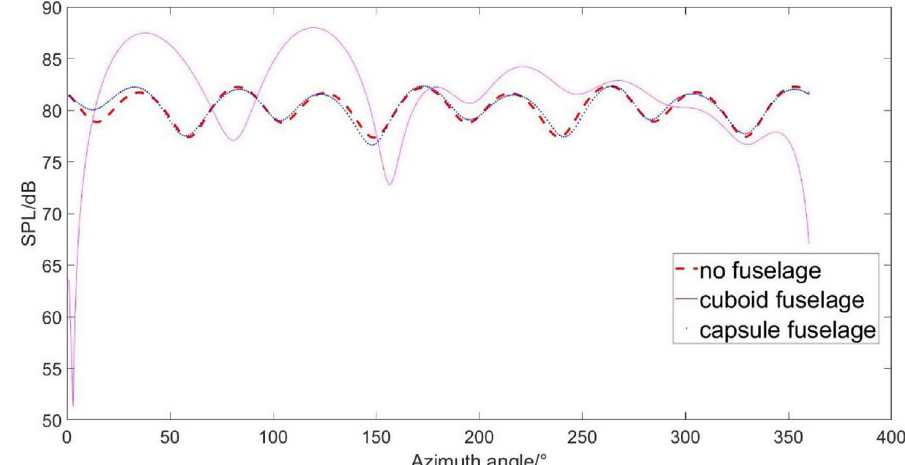
Figure 12. Acoustic noise scattering effects of cuboid fuselage and capsule fuselage. Table 3. Total and maximum SPL of helicopters with cuboid and capsule fuselages. Fuselage No fuselage Cuboid Capsule Total sound pressure level/dB 80.35 Maximum sound pressure level/dB